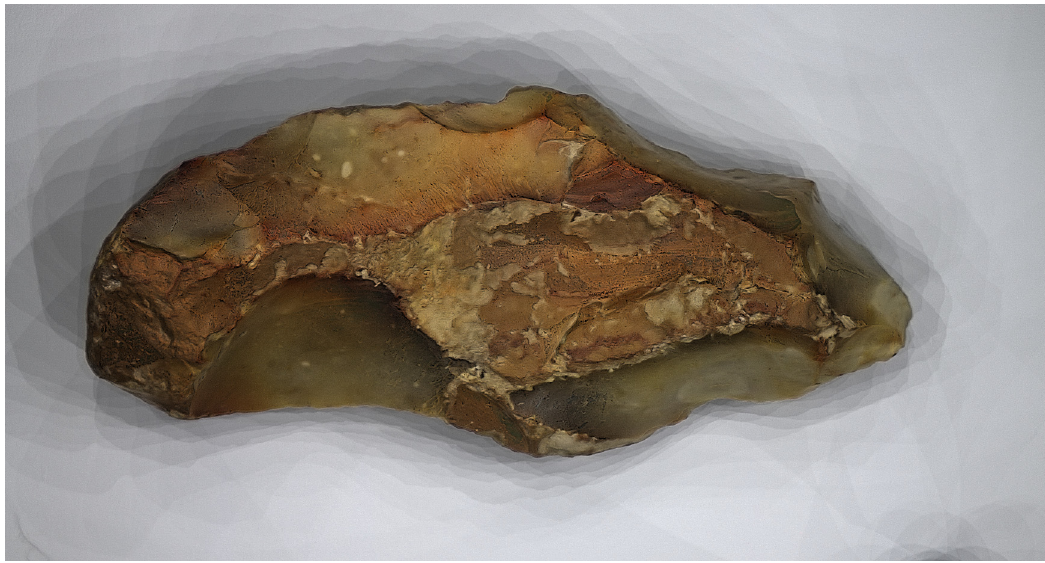
Figure 6: Temporal di ff raction pattern and mesolithic pick in H - RTI